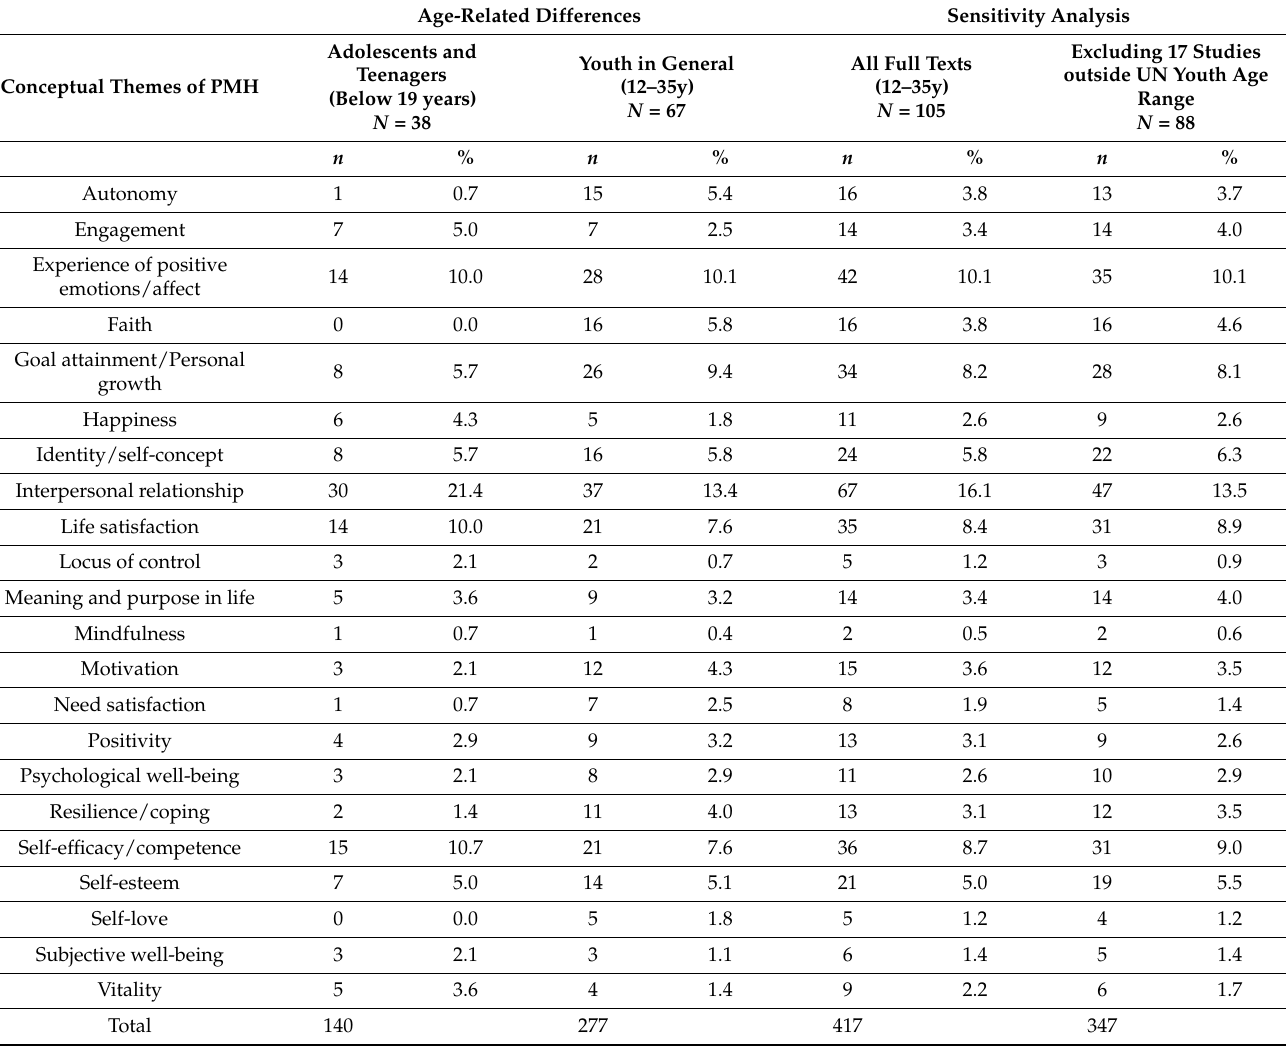
Table 3. Distribution of positive mental health concepts by age of the study population. Age-Related Differences Sensitivity Analysis